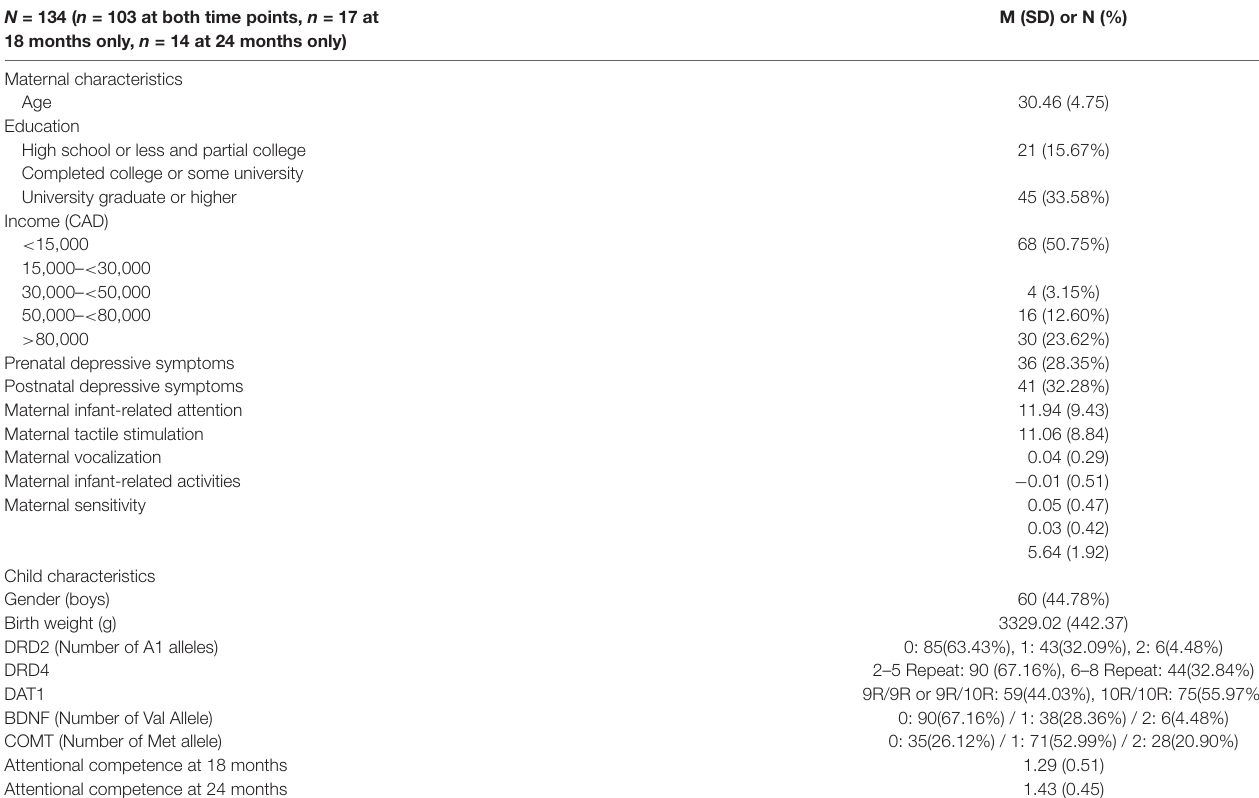
TABLE 1 | Demographic characteristics of MAVAN participants.